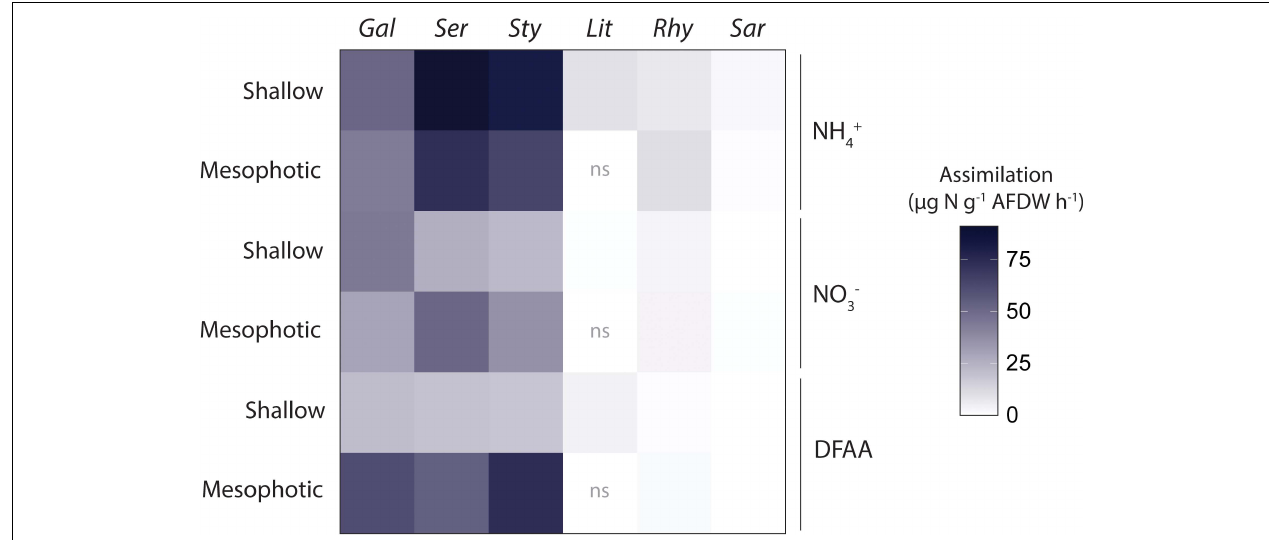
FIGURE 4 | Total N assimilation rates by the holobionts investigated. Data displayed are means of the assimilation by the host and the assimilation by the Symbiodiniaceae fraction added together. From left to right: hard corals (Gal = Galaxea fascicularis , Ser = Seriatopora hystrix , Sty = Stylophora pistillata ) and soft corals (Lit = Litophyton arboreum , Rhy = Rhytisma fulvum fulvum , Sar = Sarcophyton sp.). ns = not sampled. AFDW = ash-free dry weight. DFAA = Dissolved free amino